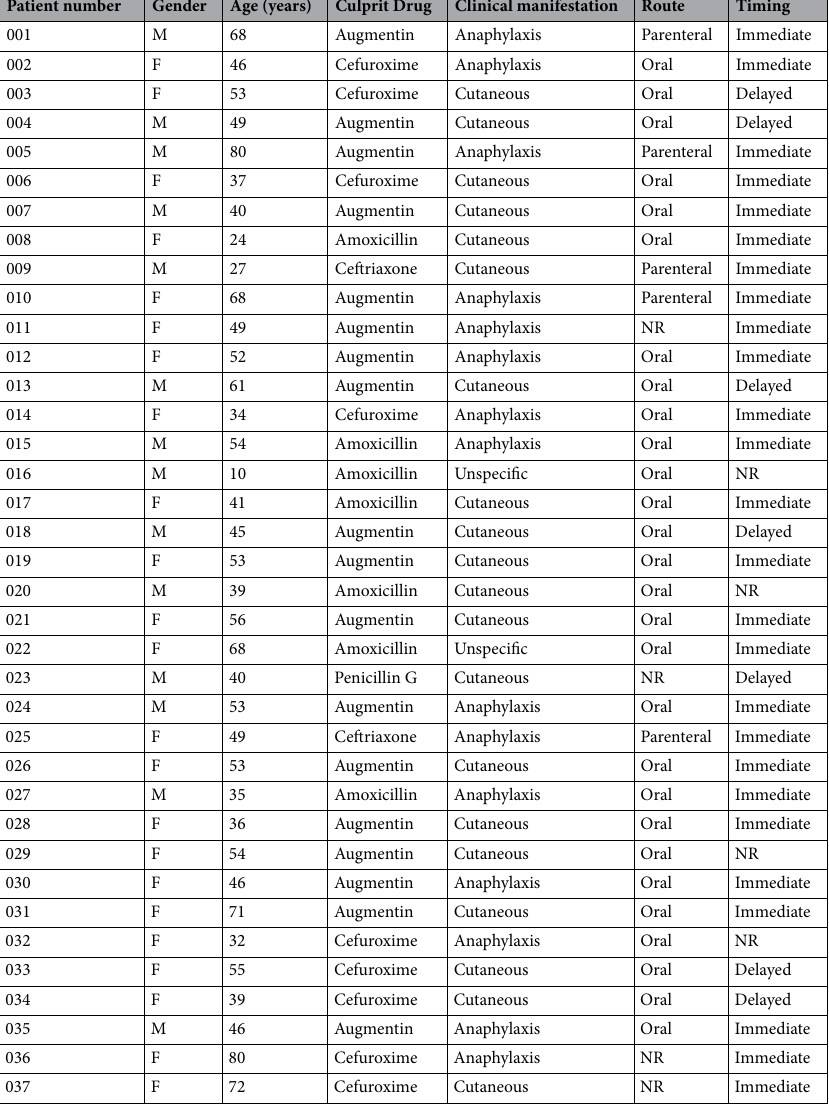
Table 1. Clinical characteristics of the cohort of allergic patients. The terms immediate and delayed refer to an allergic reaction provoked by re-exposure to a specific allergen and to late-phase allergic reactions that generally occur between 2 and 6 h after exposure to a specific allergen, respectively. F female, M male, NR not reported in the clinical